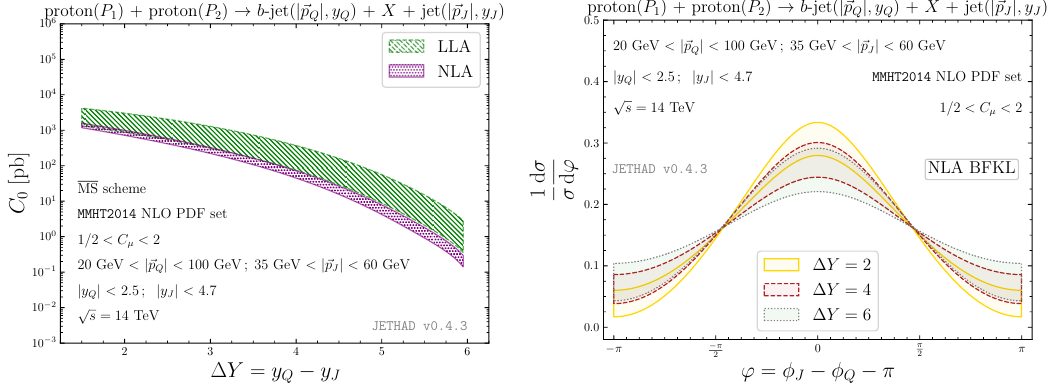
Figure 1: ϕ -summed cross section, C distribution for different ∆ Y